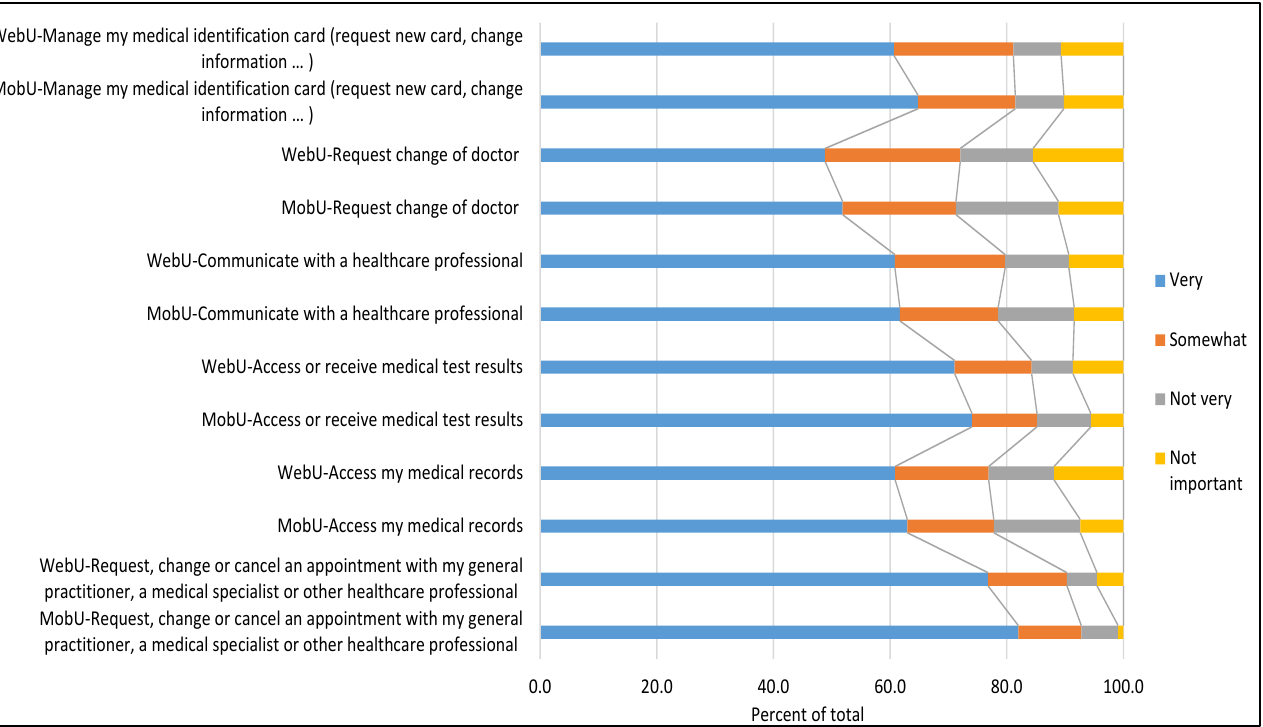
Figure 2. Ranking of the importance of health services (by user profile). Table 2. Opinions of Autonomous Community health websites (by user